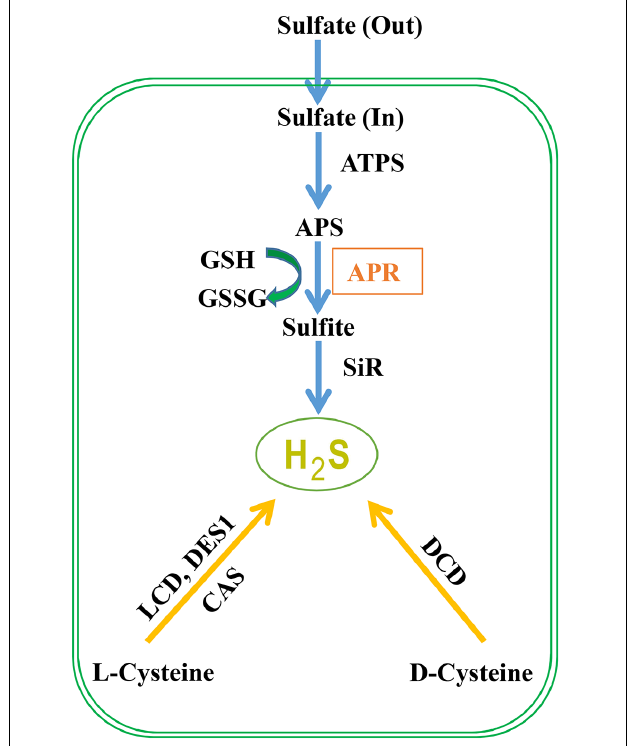
FIGURE 1 | H 2 S metabolism in plants. Sulfate absorbed by plant roots through sulfate transporters is activated to APS (5 (cid:48) -adenylylsulfate) via ATP sulfurylase. APS can be reduced to sulfite by APR (APS reductase) which is further reduced to H 2 S by sulfite reductase. Subsequently, H 2 S is incorporated to cysteine (Cys), which is the first organic product of sulfur assimilation, and the starting point for methionine synthesis. Besides, cysteine is involved in the biosynthesis of coenzymes and vitamins including coenzyme A, biotin, thiamine, lipoic acid, and SAM (S-adenosyl-L-methionine) which is the donor of methylation. Besides the route of S-assimilation, H 2 S can also be produced from cysteine via the action of L-cysteine desulfhydrase (LCD), D-cysteine desulfhydrase (DCD), and DES1 which is member of O-acetylserine thiol lyase (OASTL) family proteins. Cyanoalanine synthase (CAS) generates cyanoalanine co-formed with H 2 S with cyanide and cysteine as the